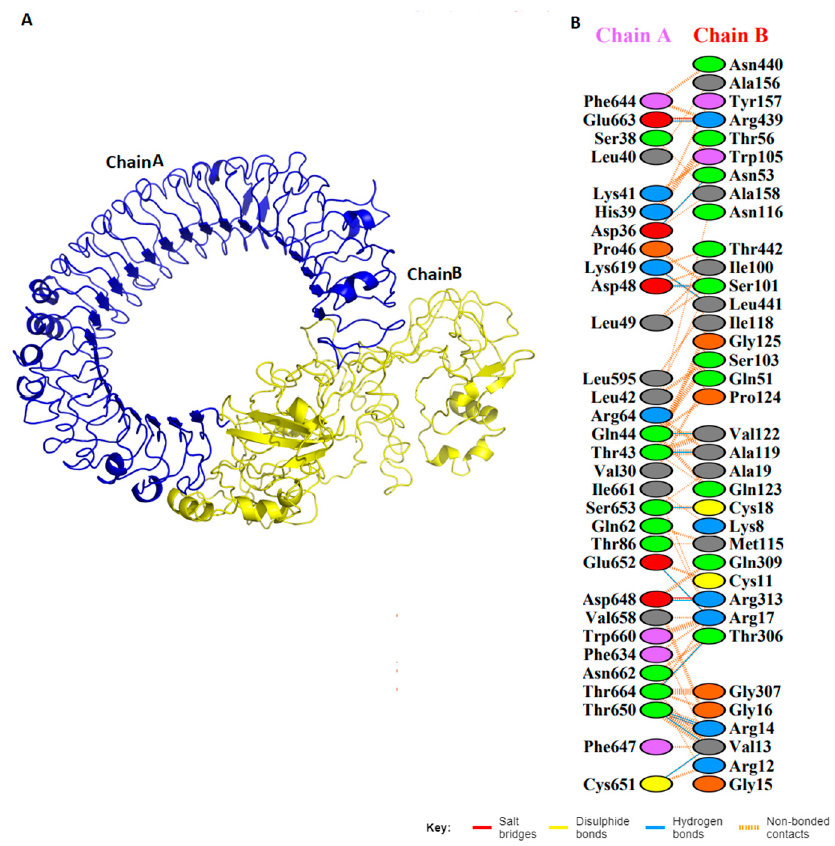
Figure 5. ( A ) Vu-TLR3–docked complex of the vaccine construct: we acquired these figures by performing molecular docking between TLR-3 and the vaccine. The blue shows TLR-3 and yellow represents the vaccine construct. ( B ) Chain A and B